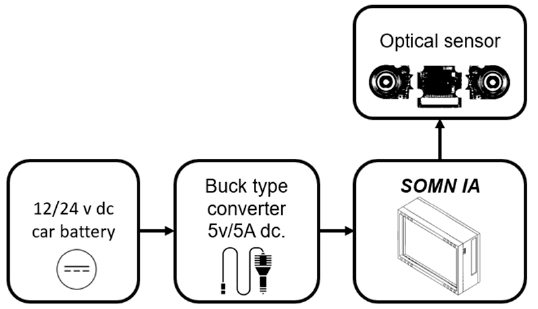
Figure 21. Connection diagram in the